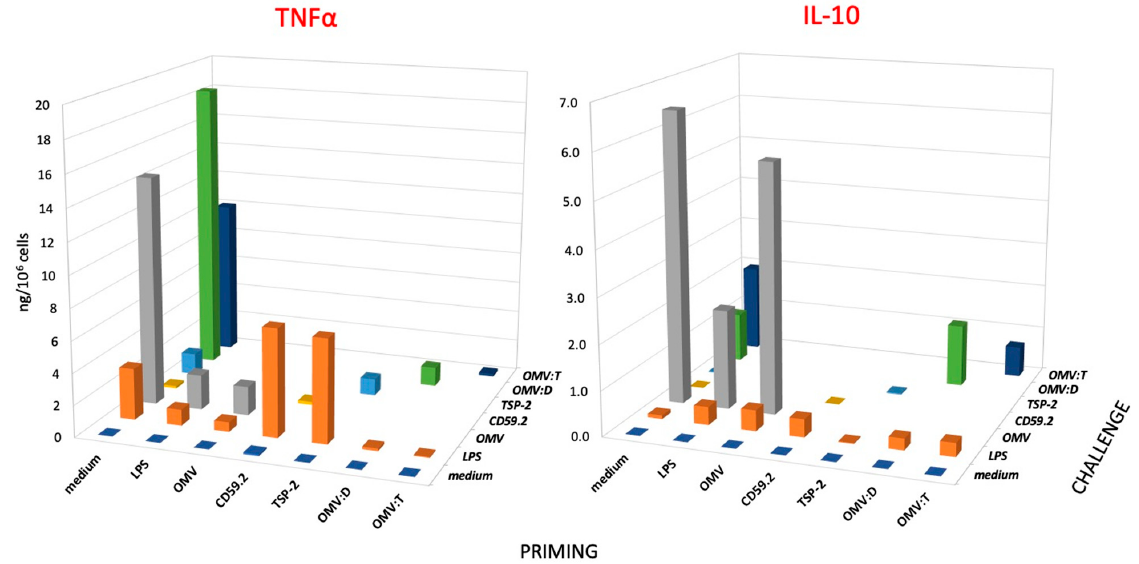
Figure 3. Secondary response of human monocytes to challenge with S. mansoni antigens. Production of TNF α (left panel) and IL-10 (right panel) of human monocytes that had been previously exposed (PRIMING in the horizontal axis) to culture medium alone (medium), LPS (1 ng/mL), unconjugated OMV (OMV), rSmCD59.2 (CD59.2), rSmTSP-2 (TSP-2), OMV:D, or OMV:T (all at 0.1 µ g antigen/mL). After 6 days of resting, cells were challenged (see depth axis CHALLENGE) with a 10x higher concentration of stimuli; medium (purple), LPS (orange), OMV (gray), rSmCD59.2 (yellow), rSmTSP-2 (light blue), OMV:D (green) and OMV:T (dark blue). LPS was used as control challenge for cells primed with every kind of stimuli. Data are the values of the 24-h cytokine production by cells from one donor representative of three examined (see Supplementary Table S3 for the values of individual donors). SD of technical replicates were always <10% and are not shown. Statistical significance is reported in the Supplementary Table